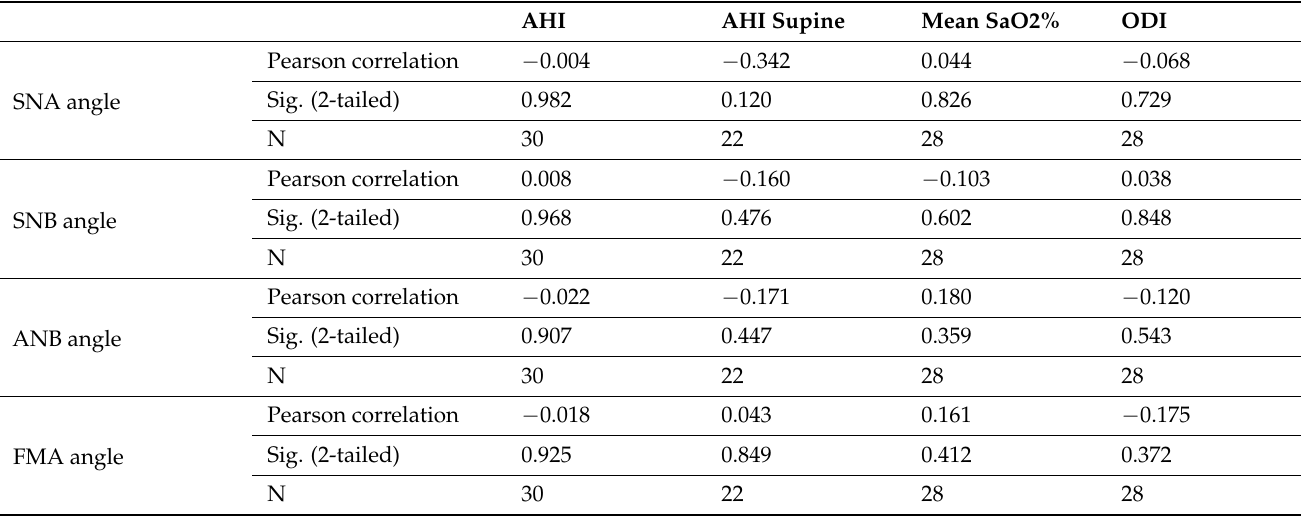
Table 2. Pearson correlation between cephalometric variables and OSA parameters (AHI, AHI supine, Mean SaO2%,